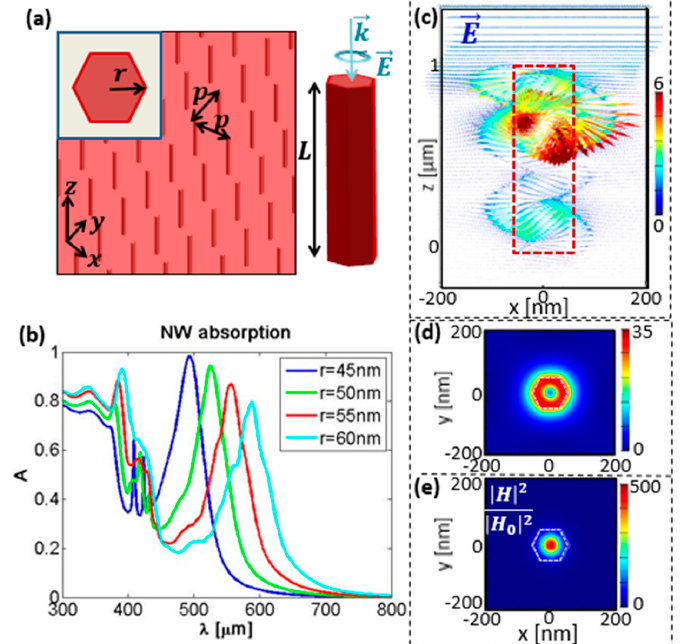
p = 400 nm, and L = 1000 nm, for D = 45–60 nm, for left circular polarization (LCP) excitation. ( c – e ) LCP excitation for r = 50 nm at the resonant wavelength λ ~525 nm: ( c ) xz cross-section of the distribution of the electric field vector; xy cross-section of the unit cell at z = 800 nm; ( d ) electric field intensity enhancement; ( e ) magnetic field intensity